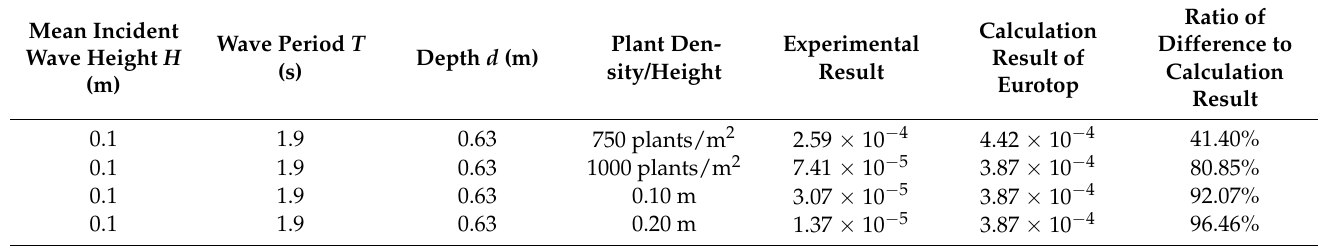
Table 5. Comparison between the per-width averaged wave overtopping of the vegetated